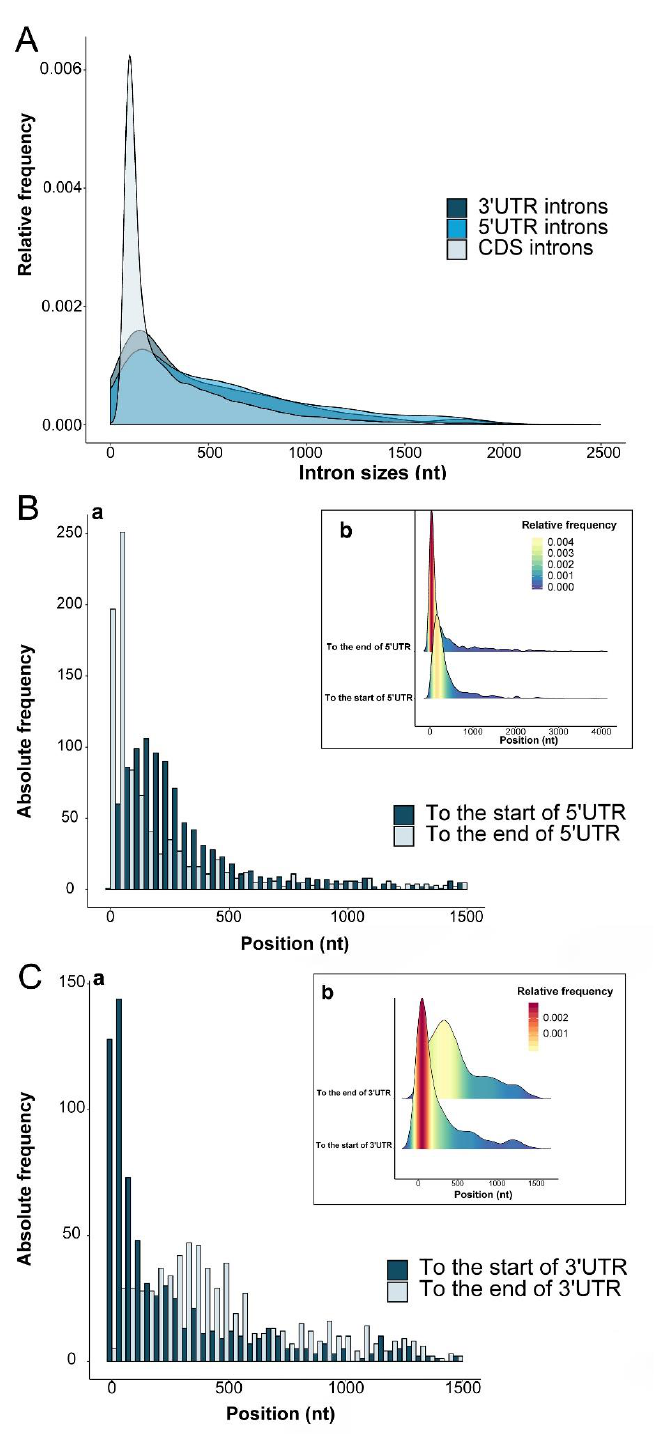
Figure 2. Length distributions of 5 (cid:48) UTR, 3 (cid:48) UTR and CDS introns ( A ) and position distribution of 5 (cid:48) UTR introns ( B ) and 3 (cid:48) UTR introns ( C ) relative to the beginning and end of the associated UTRs. For Figure 2A, the horizontal axis represents the size of the intron, and the vertical axis represents the proportion of the introns of di ff erent sizes. For Figure 2B,C, (a) Blue bars represent the observed positions of 5 (cid:48) UTR introns relative to the beginning of the 5 (cid:48) UTR and 3 (cid:48) UTR introns relative to the beginning of the 3 (cid:48) UTR (terminate the codon proximal end). Light blue bars represent the observed positions of 5UIs relative to the end of the 5 (cid:48) UTR (i.e., the start codon ATG) and 3UIs relative to the end of the 3 (cid:48) UTR. (b) Sierra of UIs relative to the end of the UTR and the end of the UTR with color